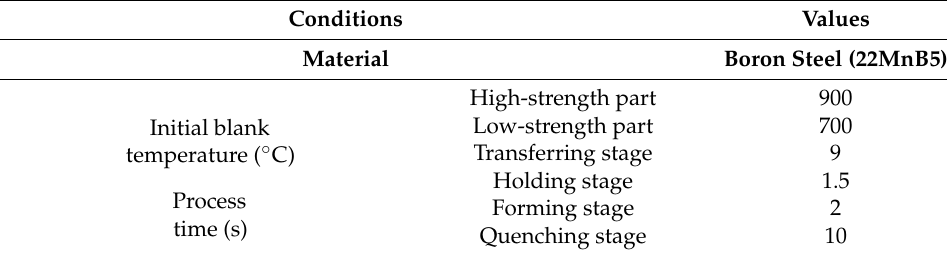
( b ) Figure 4. Results of FE simulation for hot stamping: ( a ) thinning distribution after forming stage and ( b ) temperature distribution after quenching stage. 2.3. Design of CFRTP Reinforcement In this study, structural analysis was performed and genetic algorithms (GAs) were used to determine the thickness and lay-up angle of the CFRTP part designed to replace a SABC1470 steel part (steel grade for hot stamping). Figure 5a shows the FE model used for the structural analysis, and the mechanical properties of the twill weave CFRTP pre- preg were taken from Reference [18]. The CFRTP part was modeled as a shell element whose material properties were assumed to be orthotropic. Figure 5b shows the results of the structural analysis for various thicknesses. As a result, the thickness of the CFRTP was determined to be 2.75 mm (11 plies) and GAs were applied for the lay-up optimization. The initial population is generated by the random selection method, and the parameters